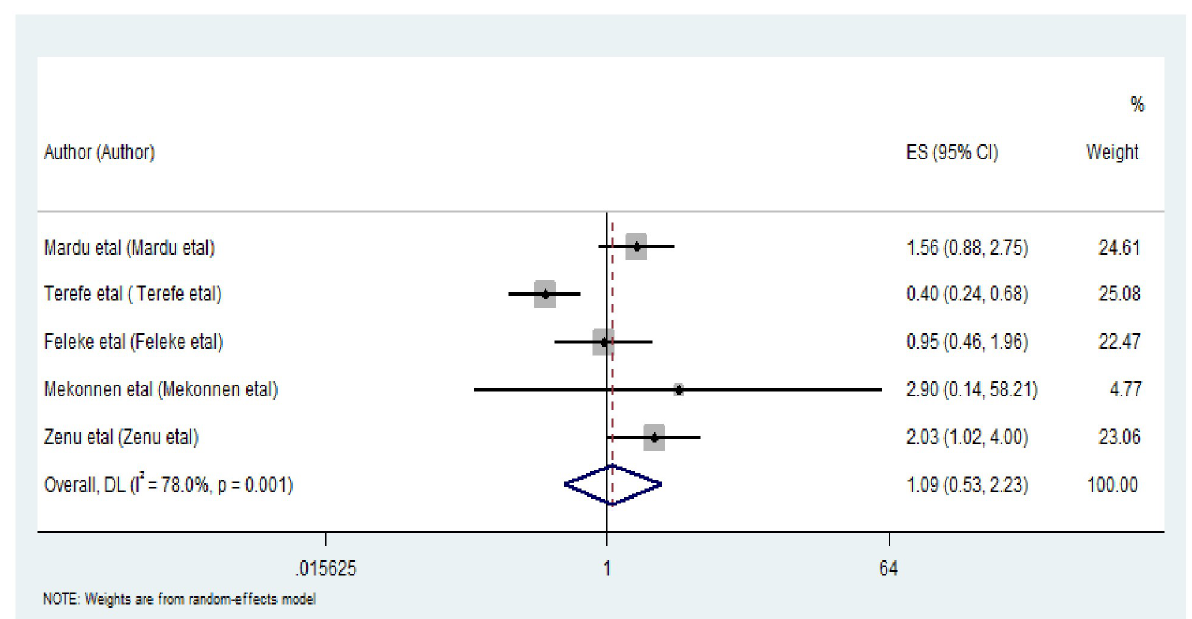
Fig 8. The pooled odds ratio of the association between finger nail status and intestinal parasitic infection among street dwellers and prison inmates.